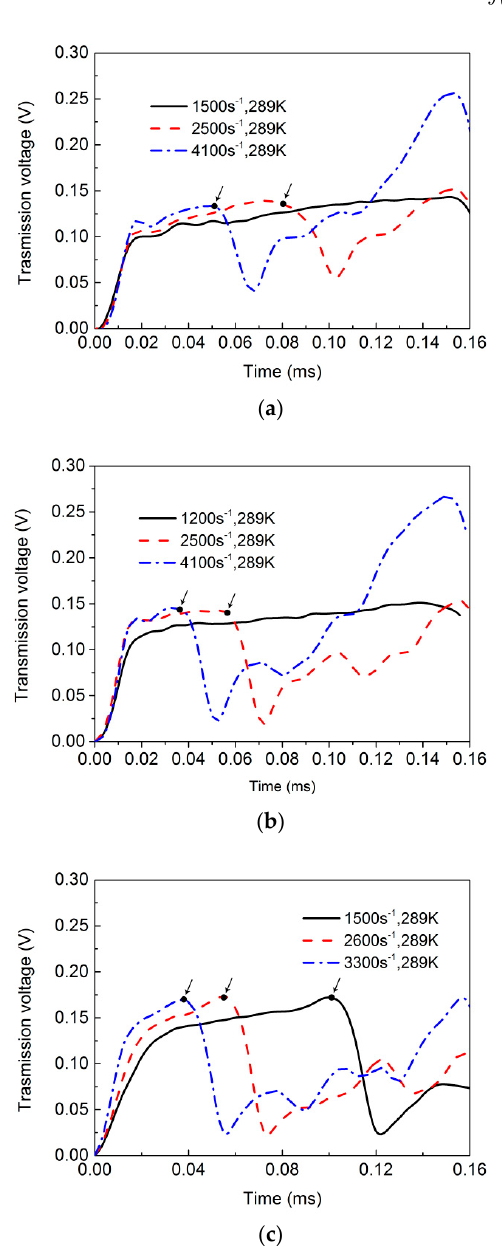
Figure 11. Transmission voltage signal of materials under dynamic compression conditions: ( a ) TC-4, ( b ) AM-P-TC-4, and ( c ) AM-T-TC-4. Figure 12 shows the corresponding relationship between the maximum strain of the three materials TC-4, AM-P-TC-4, and AM-T-TC-4 (calculated according to Equation (9)) in the first loading cycle under normal temperature conditions and the deformation strain rate, and the deformation state of the corresponding specimen. Compared with the traditional TC-4 material, the TC-4 titanium alloy material prepared via the 3D-printing process was more prone to fracture due to adiabatic shear under the same deformation conditions. In addition, the maximum fracture strain of the material in different printing directions was also different. Under a strain rate of 2500 s − 1 , the fracture strain of the tra-